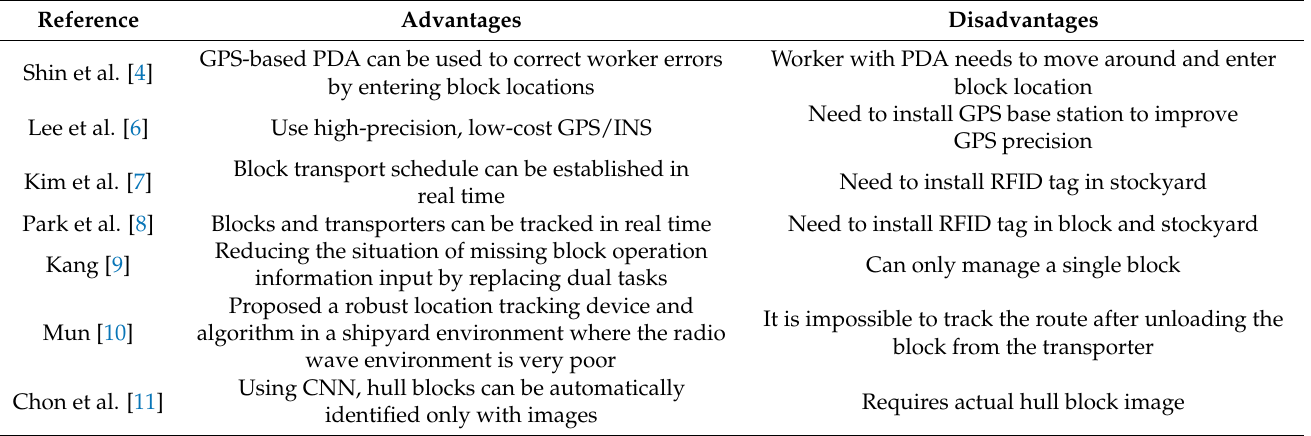
Table 1. Advantages and disadvantages of the tracking locations of ship block